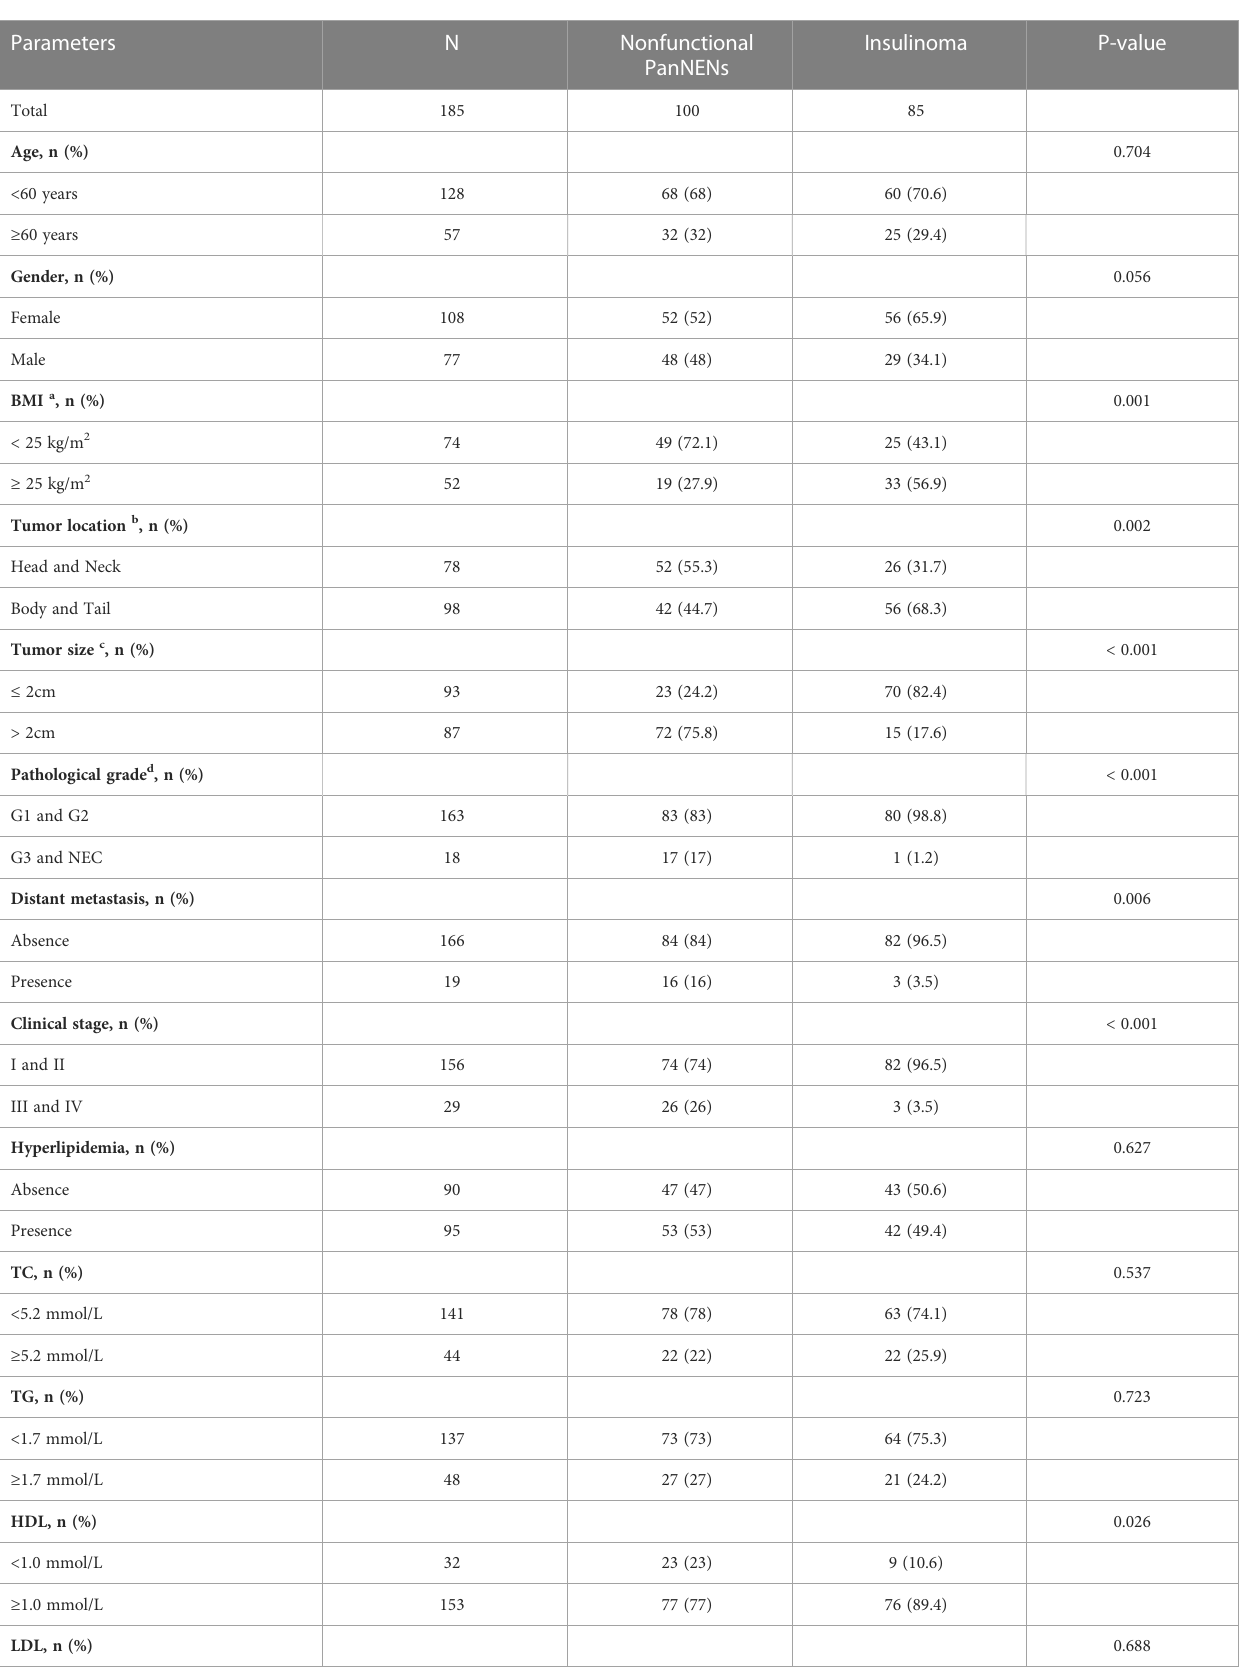
TABLE 1 Clinicopathological characteristics of patients with insulinoma and nonfunctional